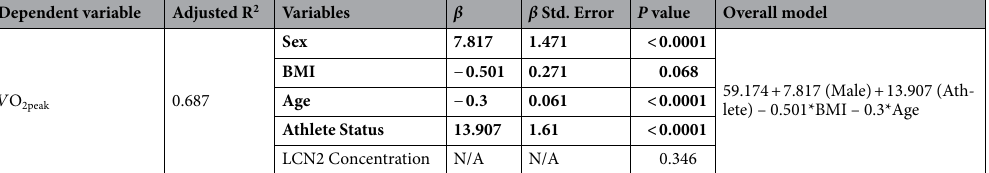
Table 7. Sensitivity analysis performed on V O 2peak testing cohort demographic characteristics and LCN2 concentration. Significant contributors to the model are bolded, with their specific contributions shown in the ˙ V overall model column. O 2peak maximal aerobic (cardiorespiratory) fitness.